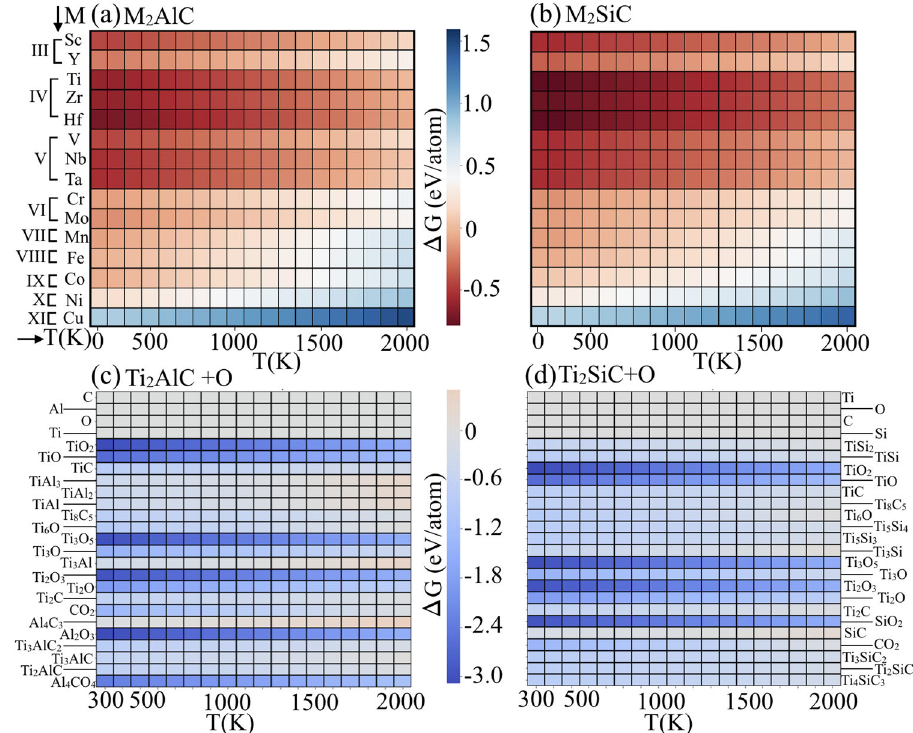
Fig. 2 Gibbs formation enthalpy prediction of MAX phases. Stability heat map for a M 2 AlC, and b M 2 SiC MAX phases. M elements organized by periodic group, arranged by increasing valence electron count. Also see SISSO predicted Δ G form in Table S3 of other binary and ternary phases. c – d Heat map of competing phase for Ti 2 AlC and Ti 2 SiC MAX phases during oxidation process in presence of static oxygen (O 2 ) at temperatures 300 – 2000